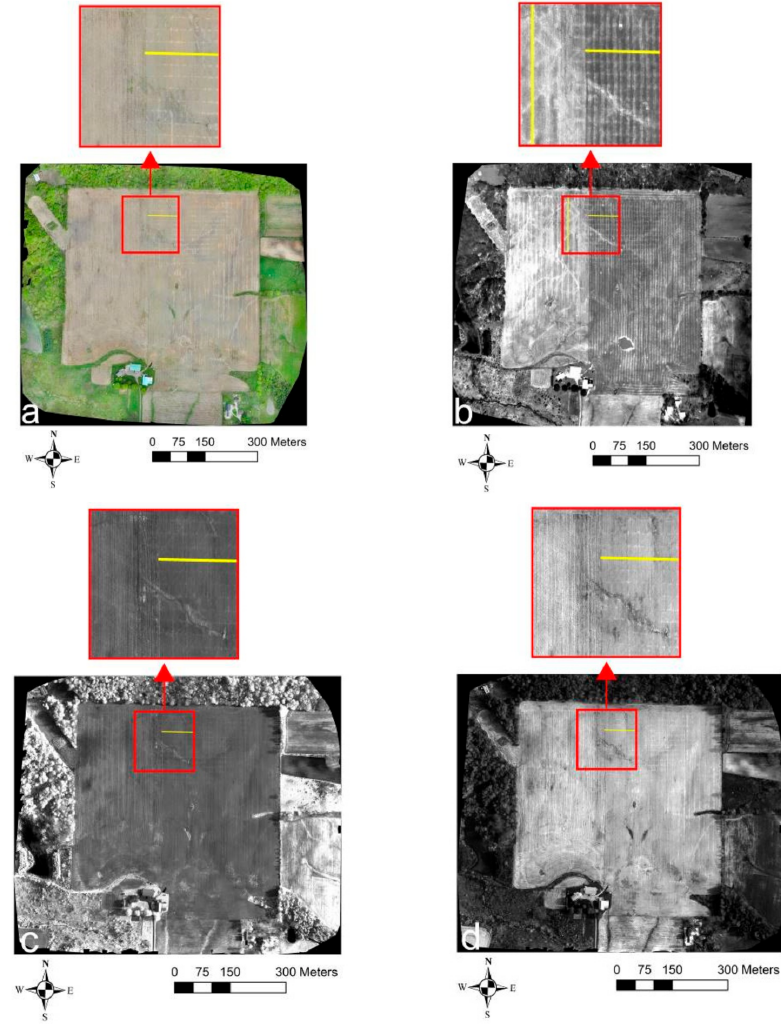
Figure 5. Site-1 UAV survey results from 6 May 2019: ( a ) VIS-C, ( b ) TIR, ( c ) NIR, and ( d ) red orthomosaic imagery. Solid yellow lines indicate the drain lines’ directional